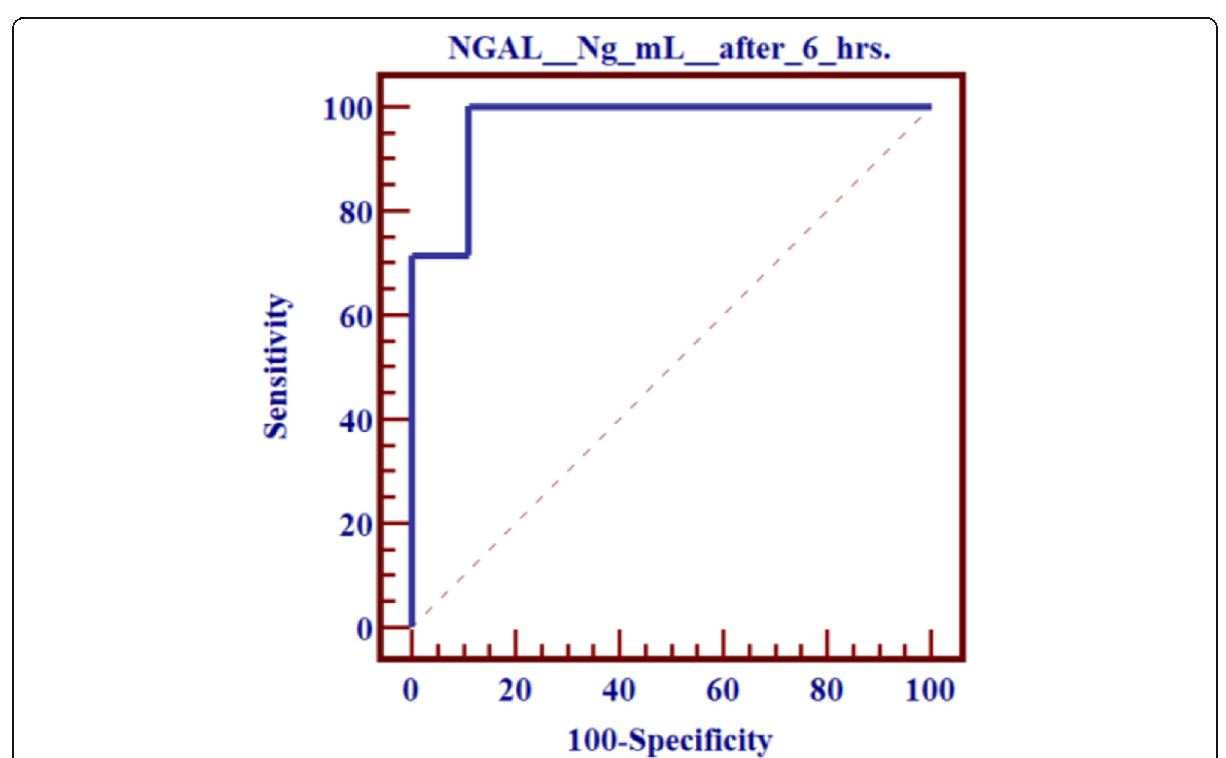
Fig. 3 Receiver-operating characteristic (ROC) curve of plasma NGAL level (cut-off value = 145 ng/mL) at 6 h after operation. AUC = area under the